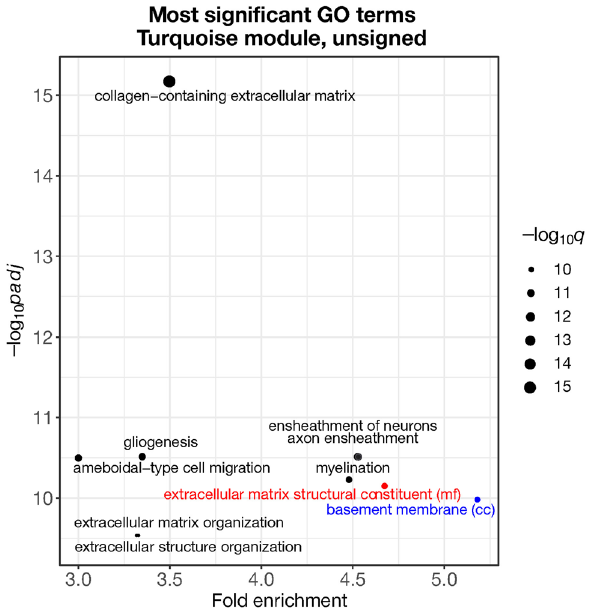
Figure 3. A bubble plot of top 10 GO terms enriched among the genes in the turquoise module. Fold enrichment is the ratio of the proportion of input genes annotated in each GO term to the proportion of all genes annotated in the same term; padj = Benjamini–Hochberg-adjusted pval; q = FDR-adjusted pval; and all terms belong to biological process except the ones marked cc (cellular component) and mf (molecular function).